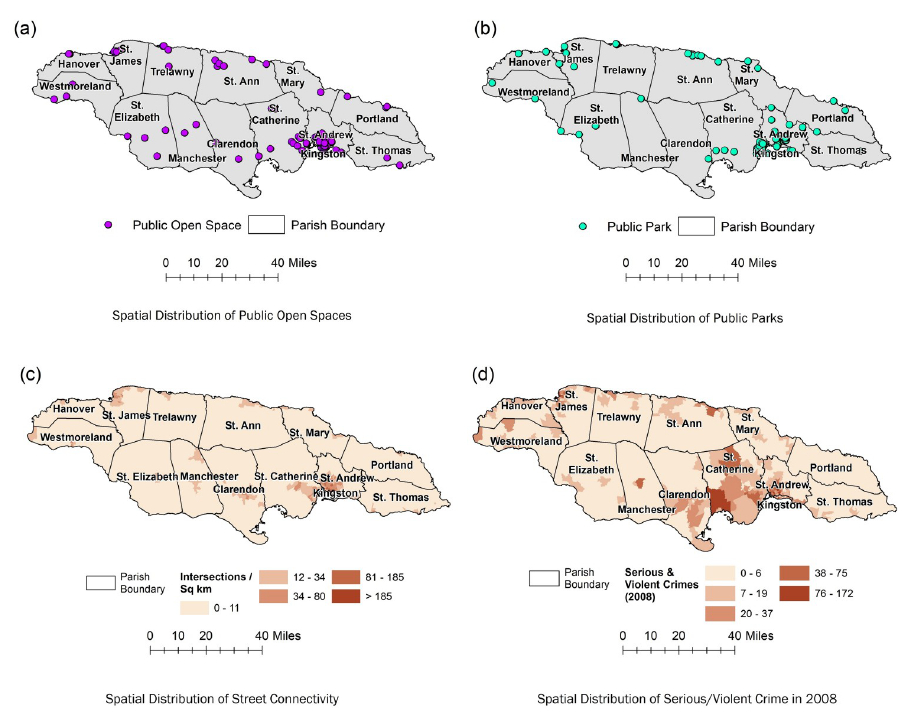
Fig 1. (a) Spatial distribution of public open spaces. (b) Spatial distribution of public parks. (c) Spatial distribution of street connectivity. (d) Spatial distribution of serious/violent crime in